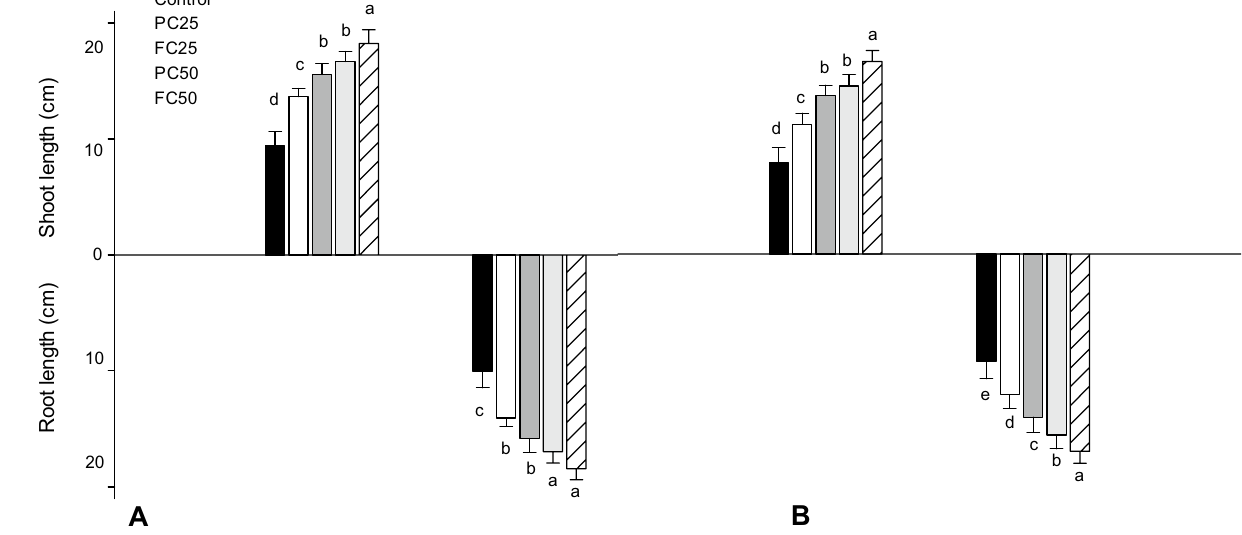
Figure 4. Effect of fungal chitosan (FC) and product chitosan (PC) on mean root and shoot length of rice varieties ( A —PTB33, B —TN1) (± SEM with five replication) (with in the bars denoted by a different letter are